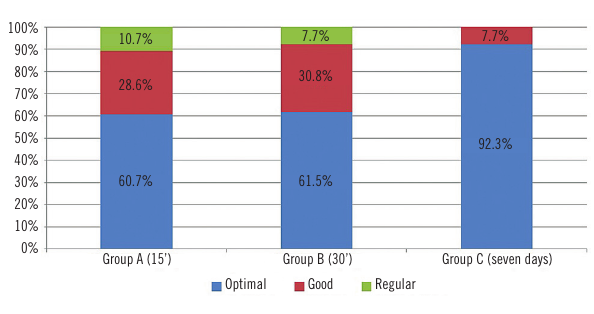
FigurE 1 − Evaluation of the staining in samples with different times of fixation. Staining classified as optimal, good and regular